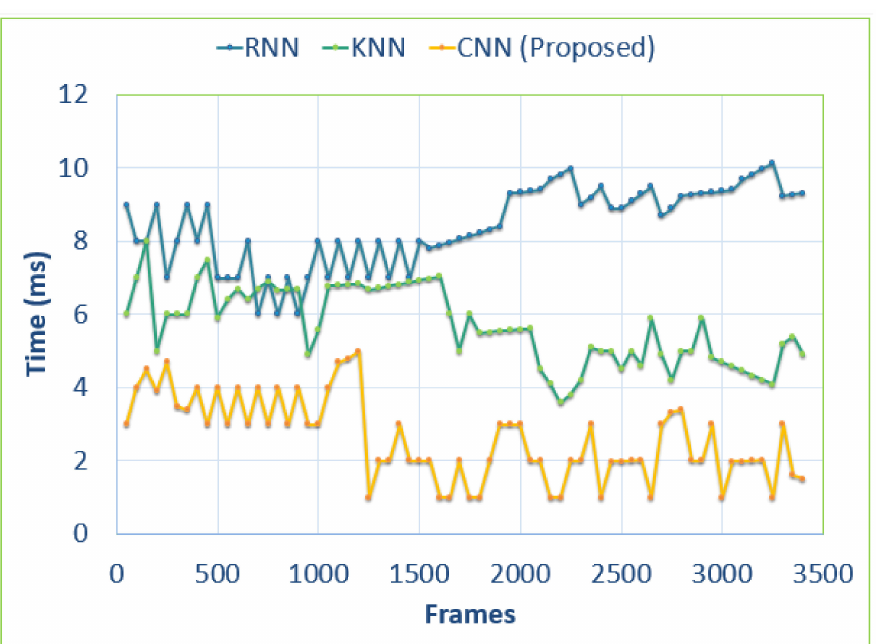
Figure 16. Comparison of the computational efficiency of our proposed model with other state of the art models over the MICC dataset.